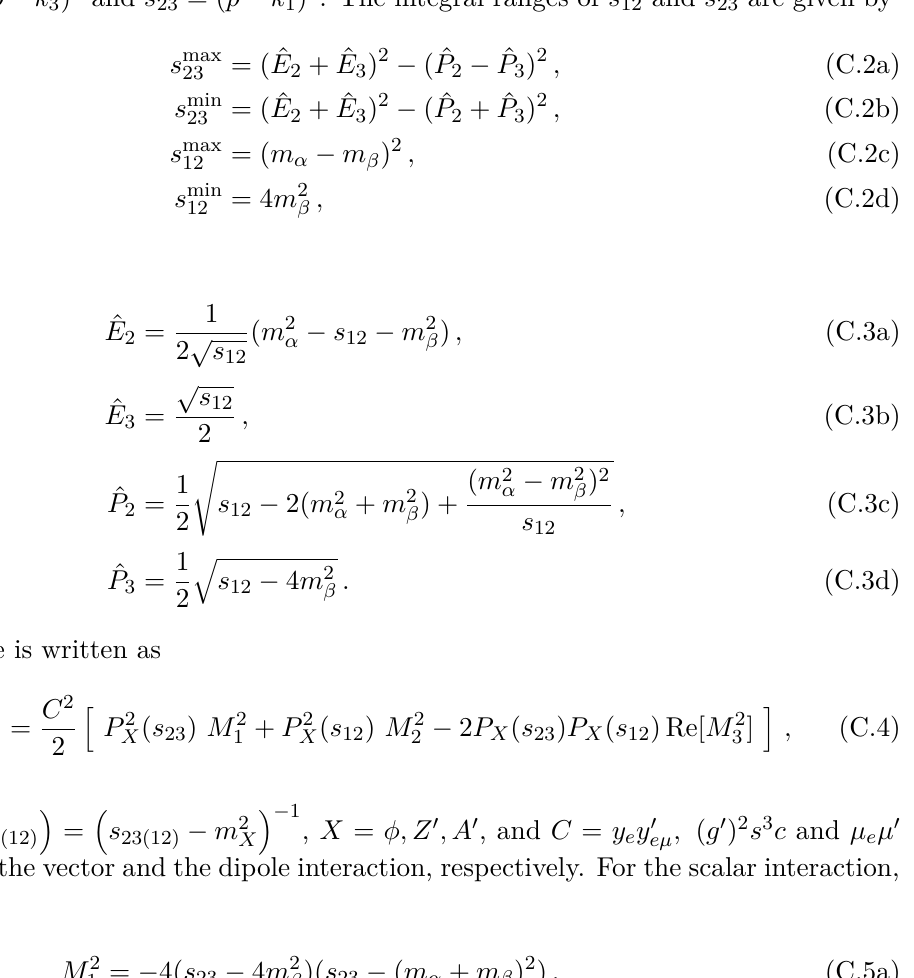
→ ‘ − ‘ − ‘ + , in which ‘ − α β β β